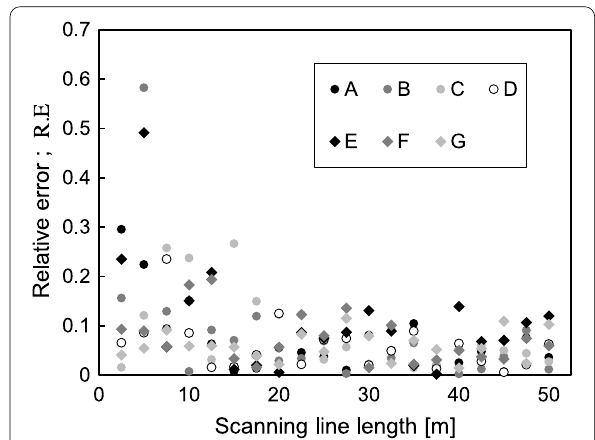
Fig. 8 Variation of the surface area per unit volume of fractures (or veins), S 0 , in each grid with the total lengths of the scanning